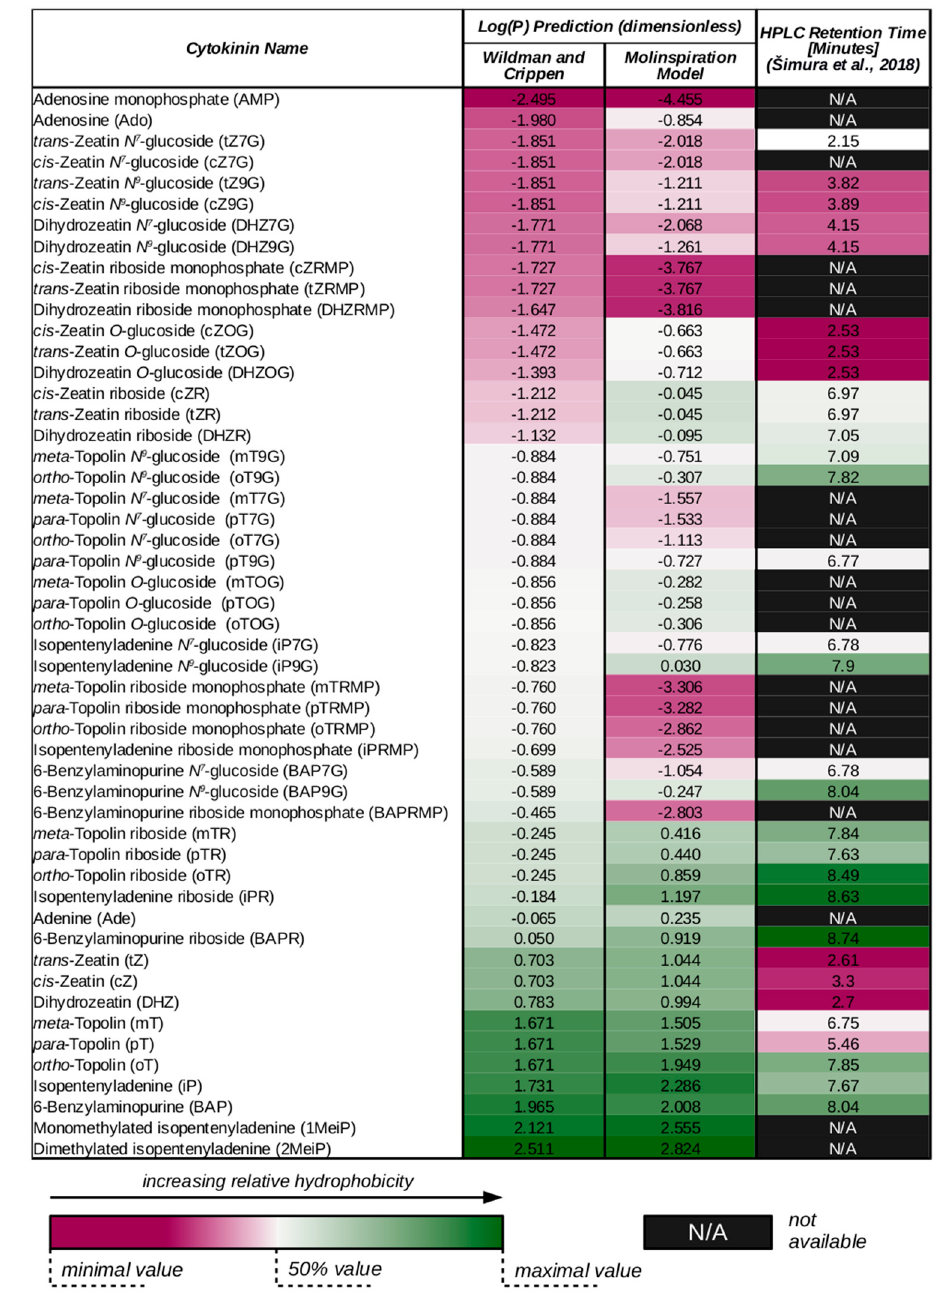
Figure 2. Hydrophobicity of various cytokinin species (CK) has been predicted using cheminformatics tools. In the second column, log( P ) values are estimated according to [54]; this method yields log( P ) as a sum of individual Wildman-Crippen atomic contributions. Calculation of Wildman-Crippen contributions has been done using RDKit: Open-source cheminformatics software (http://www.rdkit.org, accessed on 4 January 2021). In the third column, log( P ) values are estimated using a method provided by Molinspiration Cheminformatics free web services (https://www.molinspiration.com, accessed on 4 January 2021). To compare these predictions with actual experimental data, retention times of internal standards for high-performance liquid chromatography (HPLC) separation of CKs taken from [55] are given in the last column. For all three datasets, relative hydrophobicity range is visualized using the colour scale given below the table. The colour range is normalized within each column. Note that not all of the listed CKs were analysed in [55], as indicated by missing values (“N/A”).